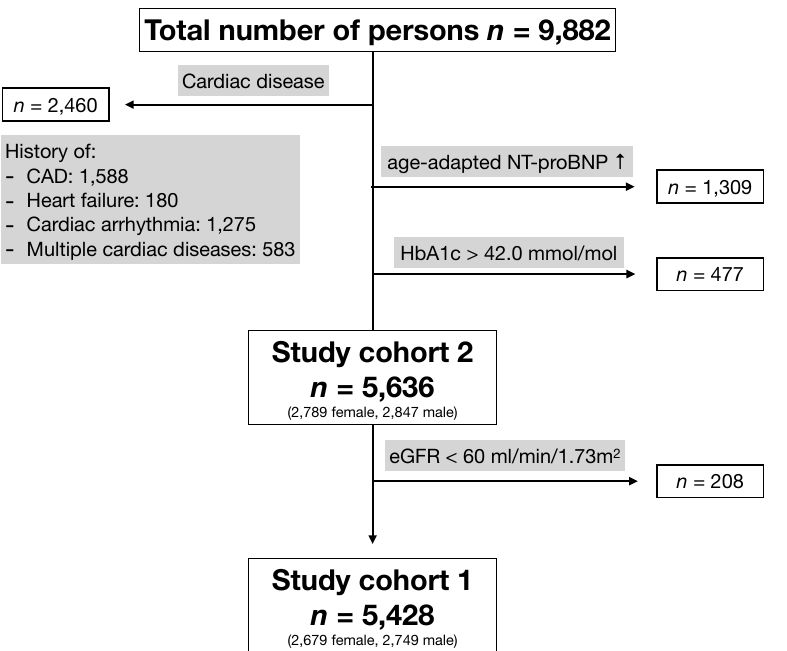
Figure 1. Study population: of 9882 adults, 2460 were excluded due to cardiac diseases, and 1786 were excluded due to abnormal NT-proBNP or HbA1c values. A total of 5636 participants were included in the analysis of hs-cTnT values in relation to sex and renal function (study cohort 2). For the calculation of age-adjusted and sex-adjusted hs-cTnT values, participants with an impaired eGFR were excluded (study cohort 1). CAD: coronary artery disease; HbA1c: hemoglobin A1c; NT-proBNP: amino-terminus pro B-type natriuretic peptide; eGFR: estimated glomerular filtration